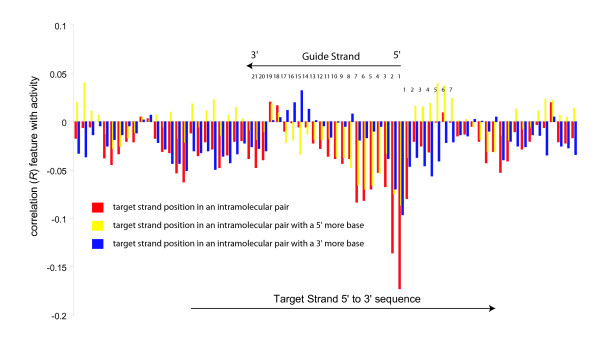
Target secondary structure position specific correlation coefficients with directionality of base pairing to RNA interference activities. Correlations of the site pairing with 5' more site are in yellow and pairing with a 3' more site are in blue.